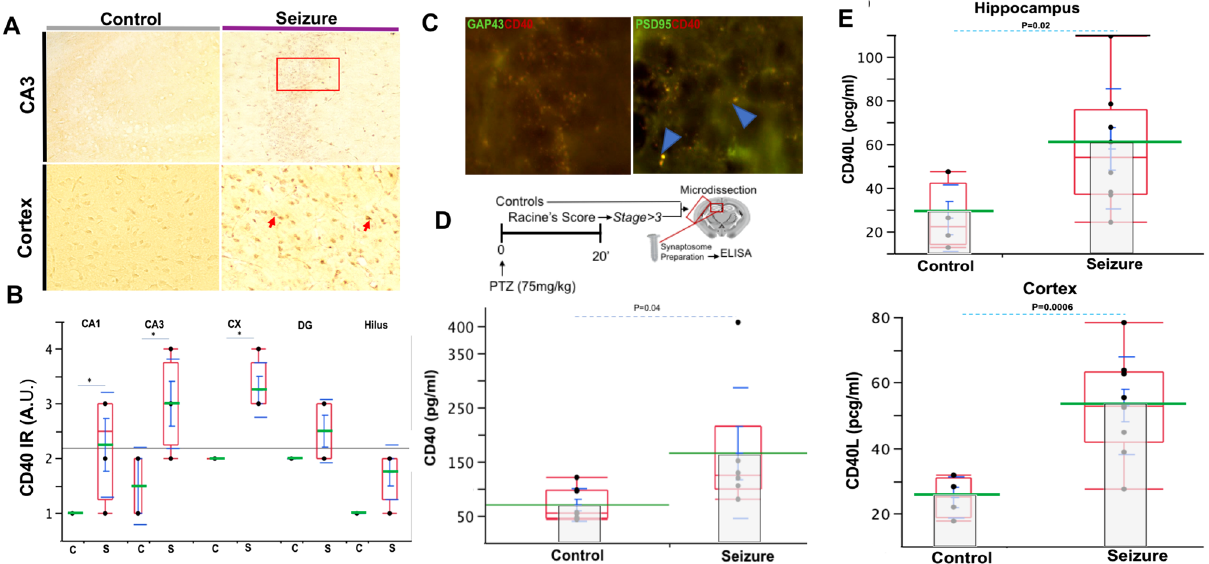
Figure 2. CD40–CD40L increase in the brain after seizure. ( A ) Representative expression of immunoreactivity (IR) against CD40 histological coronal section of CA3 hippocampal subregion and somatosensorial cortex. Note that after a seizure, compared to control, IR increase in neural cells in CA3 and accentuated in cortex respectively. ( B ) Semi-quantitative analysis of IR against CD40 from the histological coronal section of control mice (C) and after seizures (S), (n = 4). CD40 IR is highly expressed in CA1, CA3, and cortex (* = p < 0.05). ( C ) CD40 (red) is co-expressed (yellow) with representative presynaptic (GAP-43, green) and postsynaptic (PSD-95, green) terminals in the hippocampus. Blue arrows point to co-expression. ( D ) Experimental design to evaluate concentration of CD40 in synaptosomes. CD40 shows a statistically significant increase in synaptosome in mice with tonic–clonic seizures compare to control (n = 8) vs. Seizure (n = 6) p = .049). ( E ) CD40L concentration, measured using ELISA, increase in the hippocampus and cortex after seizures (n = 9) compared to controls (n = 4). Data in graphics shows individual values (black dots), mean (green line); standard error mean (S.E.M., blue bar), Standard deviation (blue line) and quartile (red the concentration of CD40L in the hippocampus (Control: mean 26.10 ± 7.6 S.E.M., n = 4 vs. Seizure: mean 57.77 ± 9.7 S.E.M., n = 8; p = 0.02; t = 2.5) and cortex (Control: mean: 24.90 ± 3.13 S.E.M., n = 4 vs. Seizure: mean: